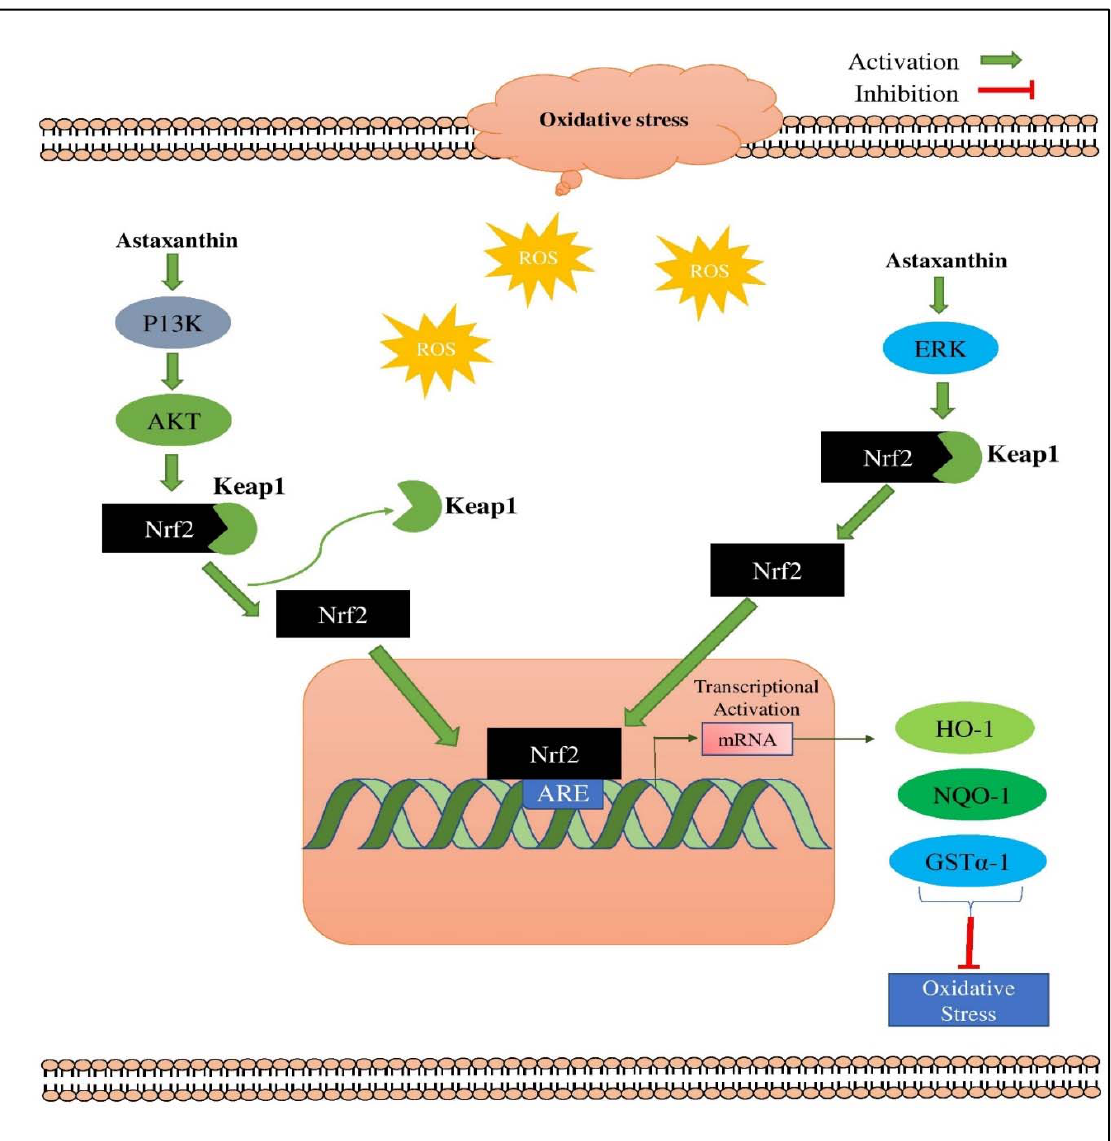
Figure 8. Mechanism of Nrf2-ARE activation by AX. The diagram was adapted and modified from Wu, H. et al., 2015 [291].